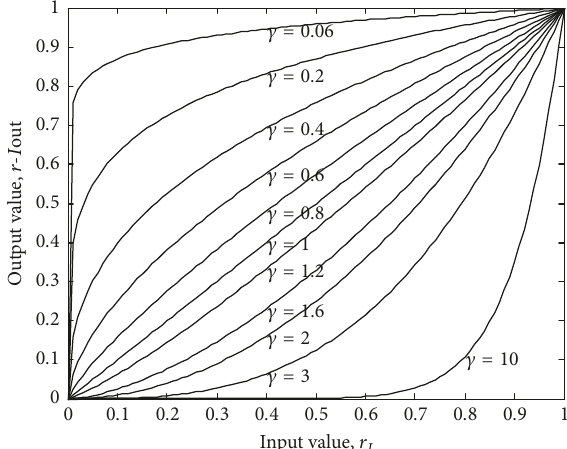
Figure 7: Gamma transforms (𝑐 = 1) .